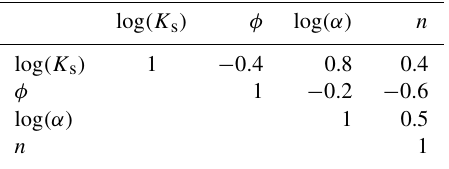
Table 2. Correlation coefficients of the soil hydraulic